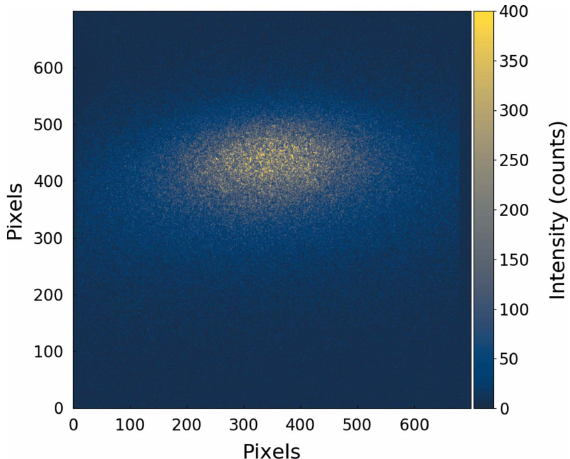
Figure 2 Dark corrected image of a diffraction peak of striped domains in a Co/Pt multilayer recorded using the AXIS-SRW camera with an integration time of 14.5 ms in HDR mode.